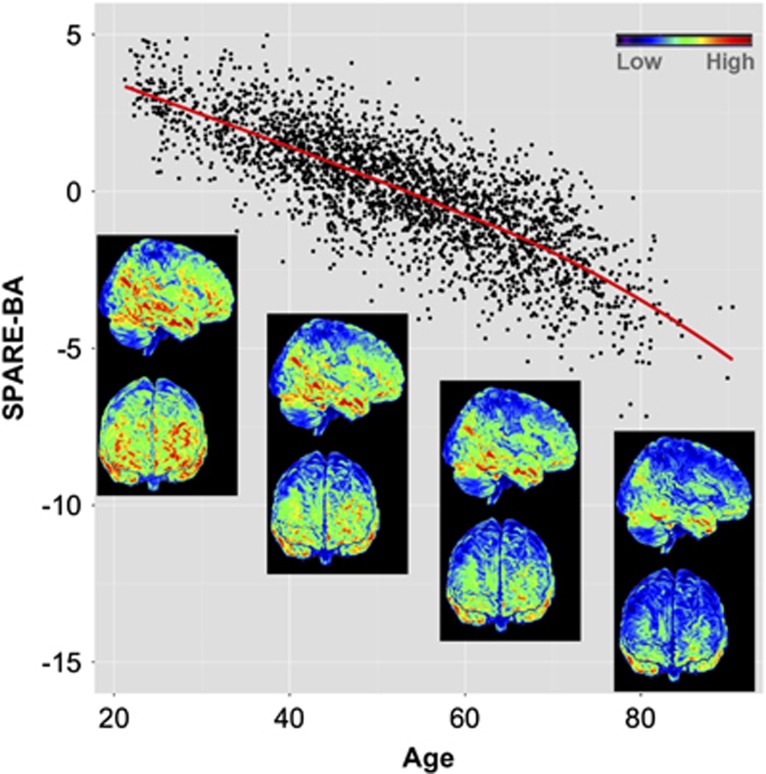
SPARE-BA values for all SHIP participants (n=2705) plotted against age. Red line represents local polynomial fitted curve. Higher/lower values indicate less/more aging-specific brain atrophy patterns, captured by the SPARE-BA index. Brain rendering shows the gray matter RAVENS (regional volumetric) maps for age groups 20–80. The color map represents lower RAVENS values (that is, less gray matter) in blue and higher RAVENS values (that is, more gray matter) in red. We observe a consistent decrease in gray matter volume in the cortex with age, which are particularly prominent in certain frontal, parietal and temporal brain regions. SPARE-BA, Spatial Pattern of Atrophy for Recognition of BA.